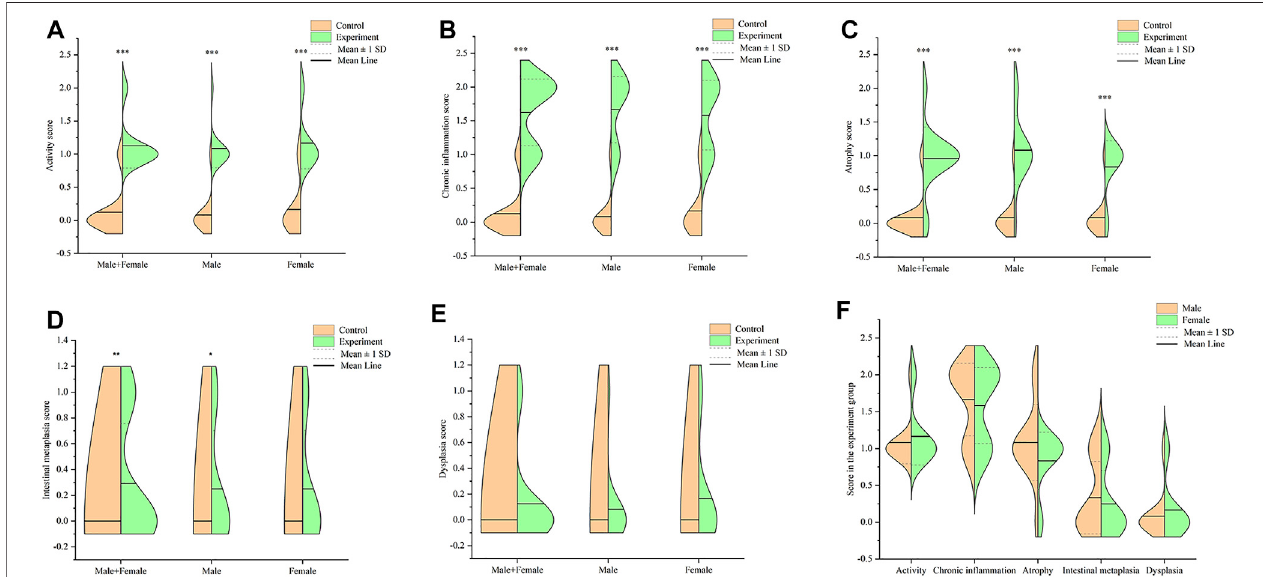
FIGURE 4 | Pathological score in the stomach tissues of mice. (A) Split violin plot showing the activity score; (B) Split violin plot showing the chronic in fl ammation score; (C) Splitviolinplotshowingtheatrophyscore; (D) Splitviolinplotshowing theintestinalmetaplasiascore; (E) Splitviolinplotshowingthedysplasiascore; (F) Split violin plot showing the gender difference of pathological score in the experiment group. * p < .05, ** p < .01, *** p < .001 versus control.